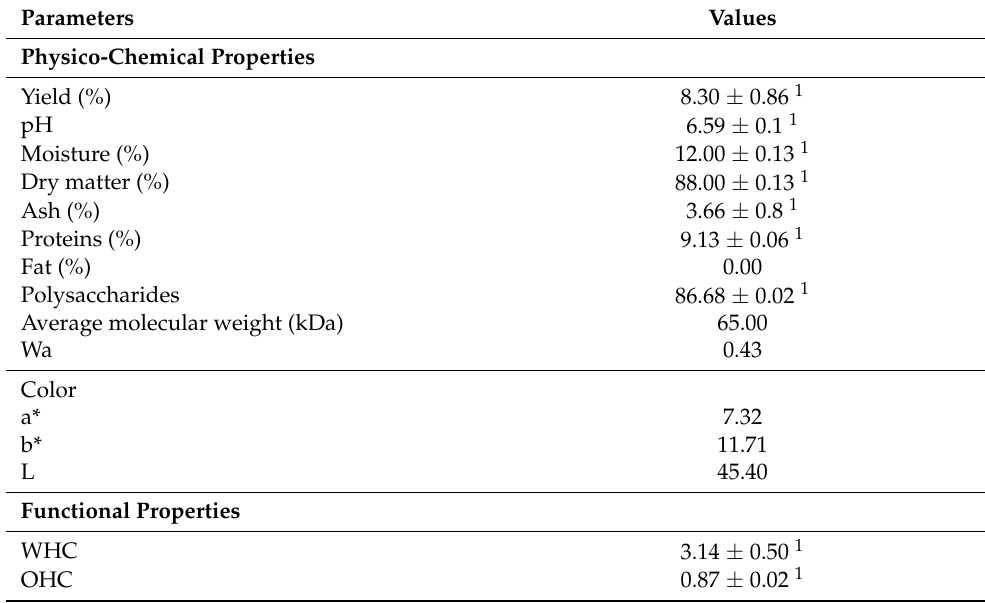
Table 1. Physicochemical and functional properties of KWSP (g water or oil/g wet sample).